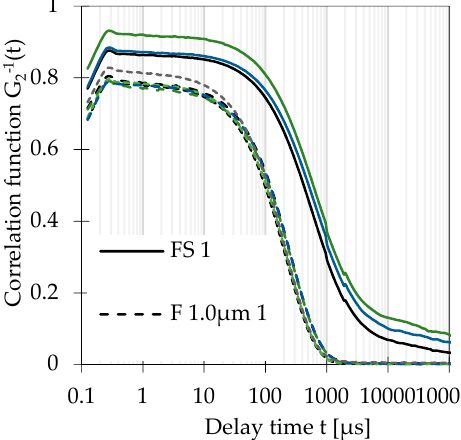
Figure 4. DLS correlation functions g 2 − 1 (t) of all replicates of kaolin suspensions: Feedstock suspensions (FS) and filtrates (F) obtained with OMNIPORE ® PTFE membranes (1.0 µ m and 0.45 µ m pore